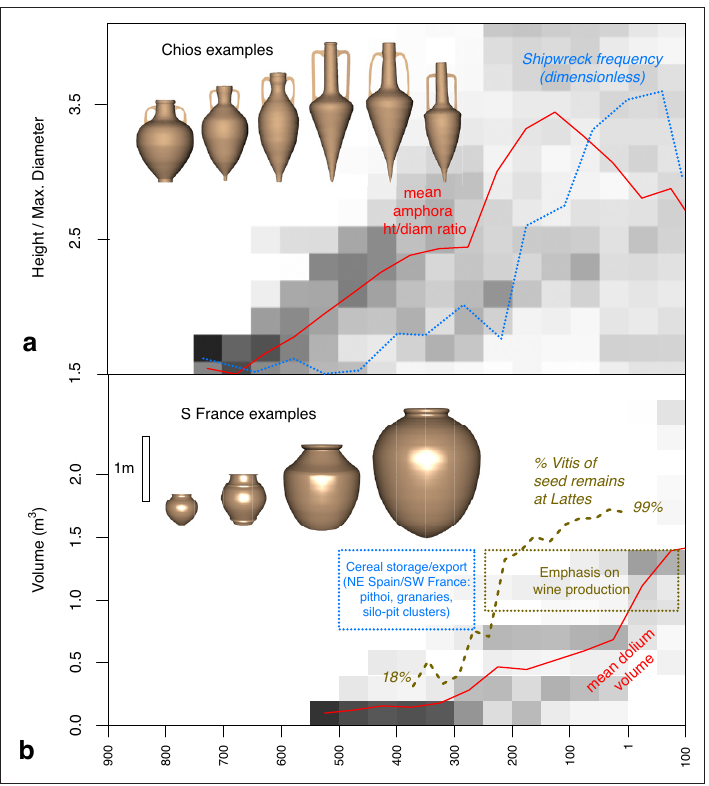
Figure 2: Storage dynamics through Iron Age containers (Figure: A. Bevan): (a) a bivariate histogram and weighted mean of amphora height-width ratios (n = 688 types, see Bevan 2014 for source data), along with the frequency of Mediterranean shipwrecks (after Wilson 2009, fig. 9.4) and (b) a bivariate histogram of large storage jar ( dolium ) volumes from southern France (n = 32 types, solid-of-revolution profiles from drawings in Marlier and Sciallano 2008; Py 1993), along with the changing percentage of grape seeds amongst all seeds from the major port site of Lattes (after Py and Buxó 2001: fig.